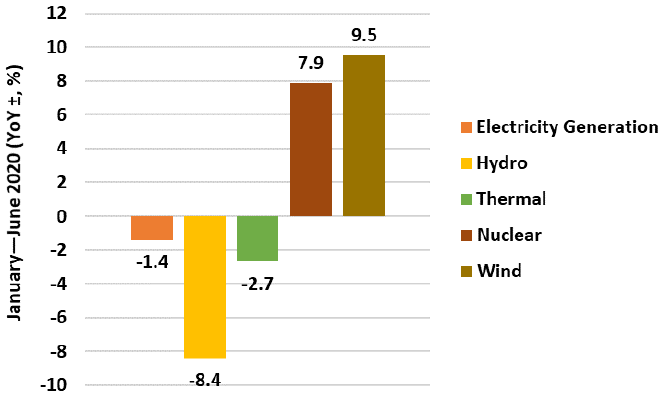
Figure 8. China’s electricity generation from January to June 2020.